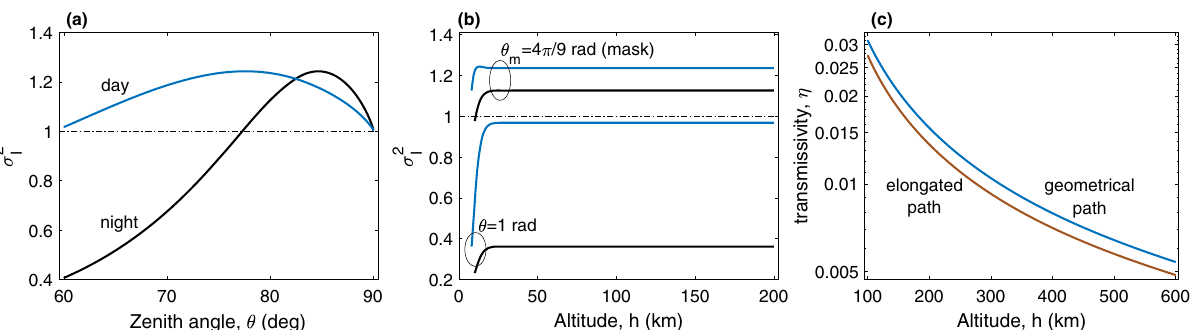
Fig. 5 Satellite communications at large zenith angle. In ( a ), we show the scintillation index of Eq. (28) versus the zenith angle, at fi xed z = 400 km. In ( b ), we plot the scintillation index of Eq. (28) versus altitude, at θ = 1 rad and θ m = 4 π /9 rad. In ( a ) and ( b ) black curves are for clear-night turbulence conditions, while blue curves are for day-time and high-wind conditions. In ( c ) we illustrate the non-trivial difference between the elongated and geometrical paths at the mask angle θ m = 4 π /9. In ( c ) we have set w 0 = 20 cm, a R = 40 cm, λ = 800 nm, h 0 = 30, α 0 ( λ ) = 5 × 10 − 6 m − 1 , and η eff = 0.5. COMMUNICATIONS PHYSICS| (2022) 5:38